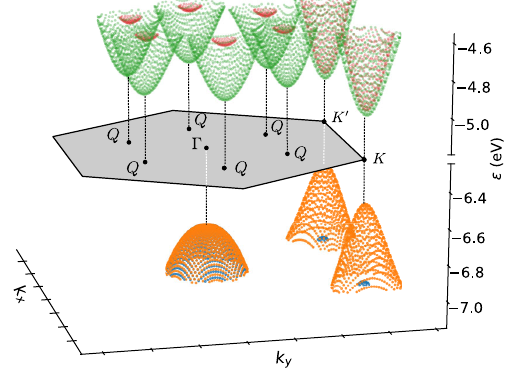
FIG. 4. The low-energy valley structure of the conduction and valence bands is common to all the TMD monolayers inves- tigated here. This figure illustrates it by showing the low-energy parts of the conduction and valence bands of WS 2 monolayers (the grey shaded hexagon represents the Brillouin zone). The top of the valence band (shown in orange and blue) is formed by a single spin-degenerate valley around Γ and a spin-split, twofold degenerate valley at the K = K 0 point. The bottom of the con- duction bands (represented in green and red) is composed of an almost spin-degenerate valley at the K = K 0 point (with degeneracy two) and a sixfold degenerate spin-split valley approximately midway between Γ and K, normally referred to as the Q point.